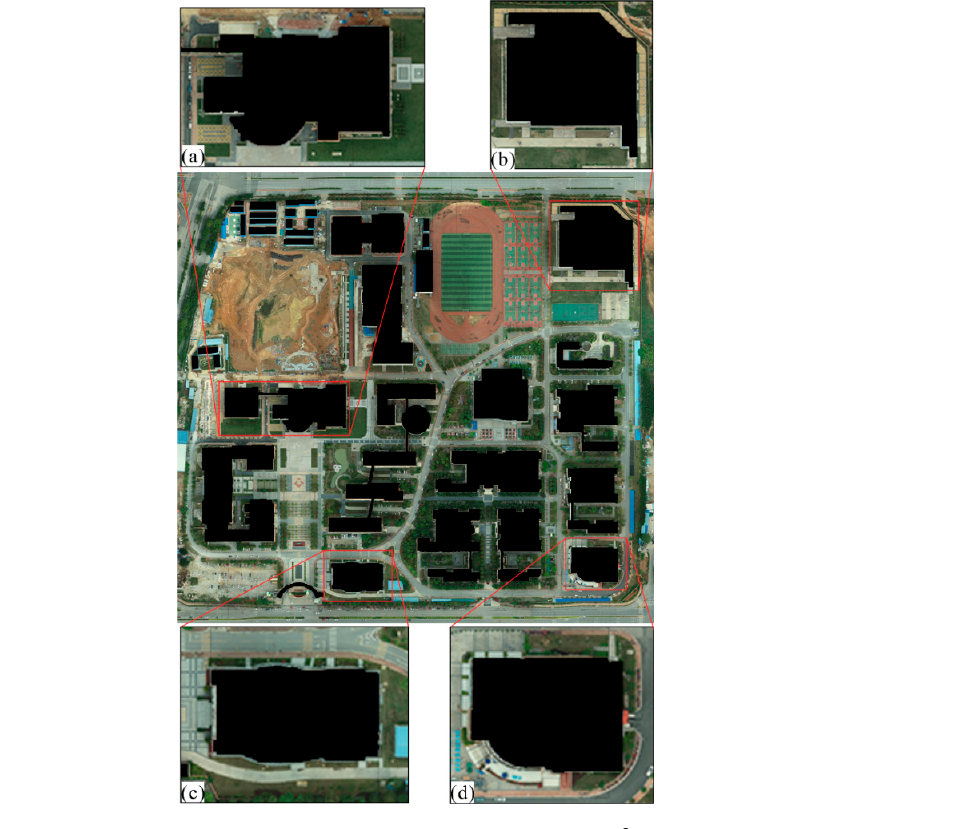
Figure 19. Generation results of DTM-based T 2 OM; ( a – d ) are enlarged windows of the four regions. Step 3. Merging DTM- and DBM-based T 2 OMs